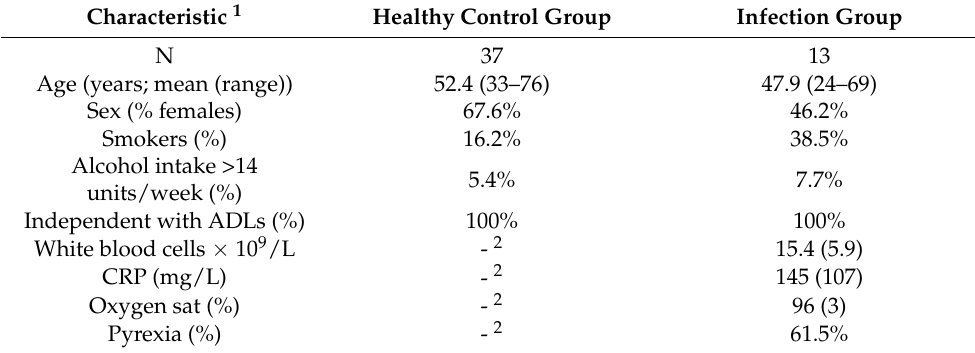
Table 1. Baseline characteristics according to the study